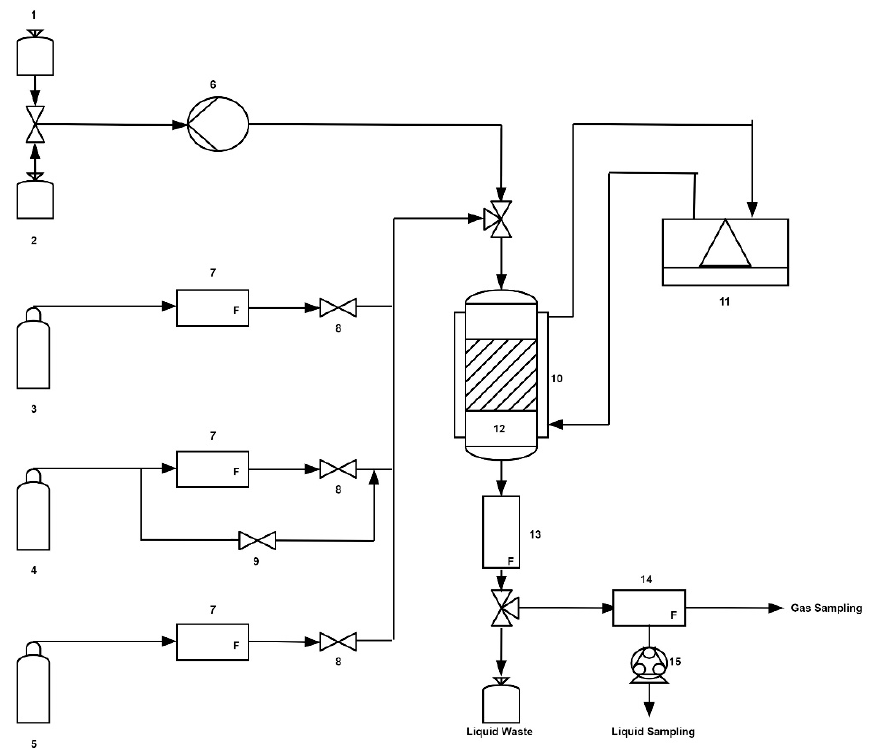
Figure 7. Schematic experimental apparatus. (1, 2) Solvent bottles, (3, 4, 5) gas bottles: CO 2 , 5%H 2 /CO 2 , O 2 (6) syringe pump, (7) mass flow controller (MFC), (8, 9) two-way valves for stopping the gas flow, (10) cooling coil, (11) thermostat, (12) trickle-bed reactor, (13) back pressure controller, (14) gas/liquid separator, (15) peristaltic pump.